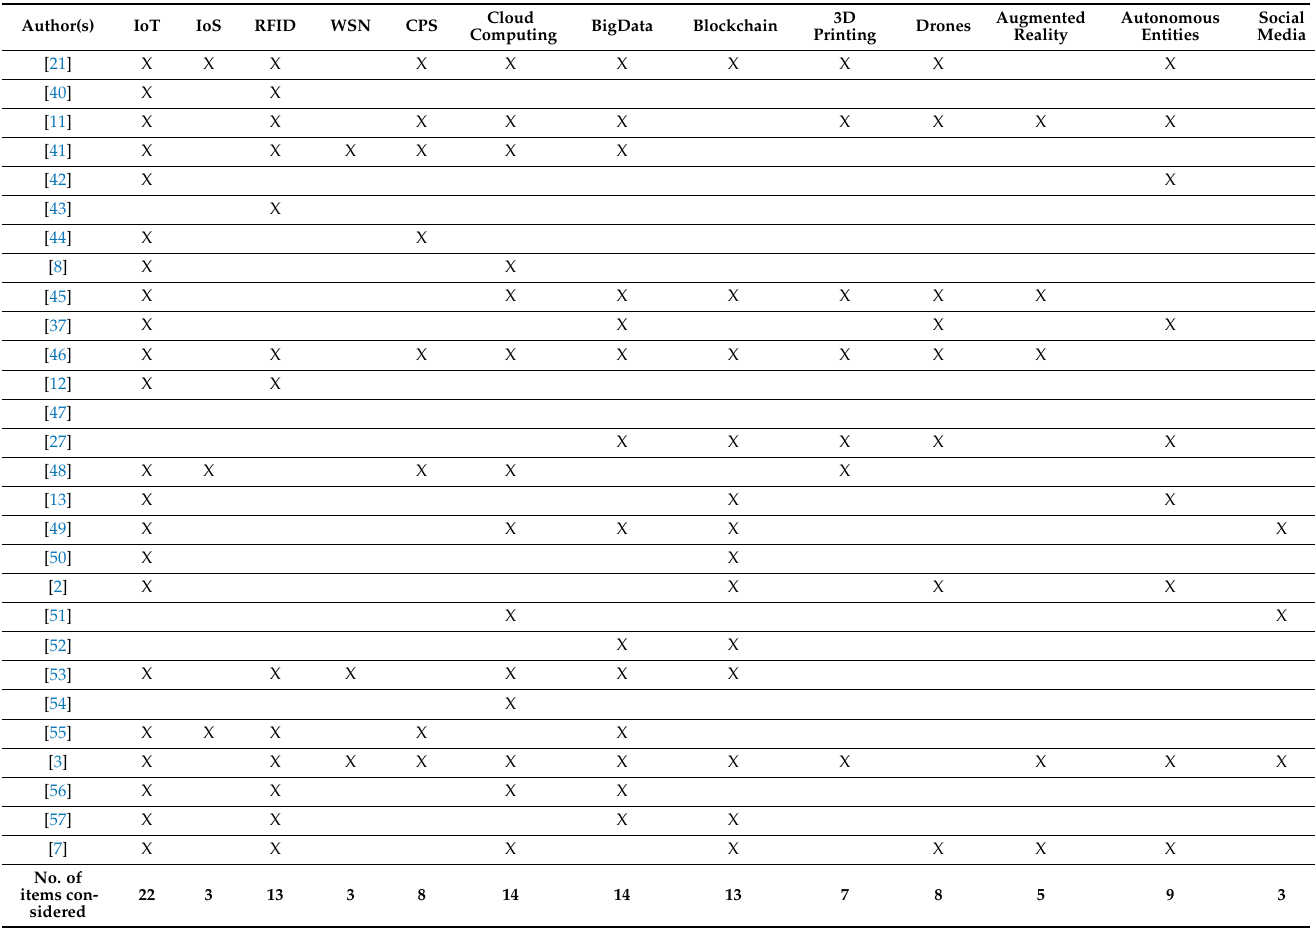
Table 4. Sub-categories for